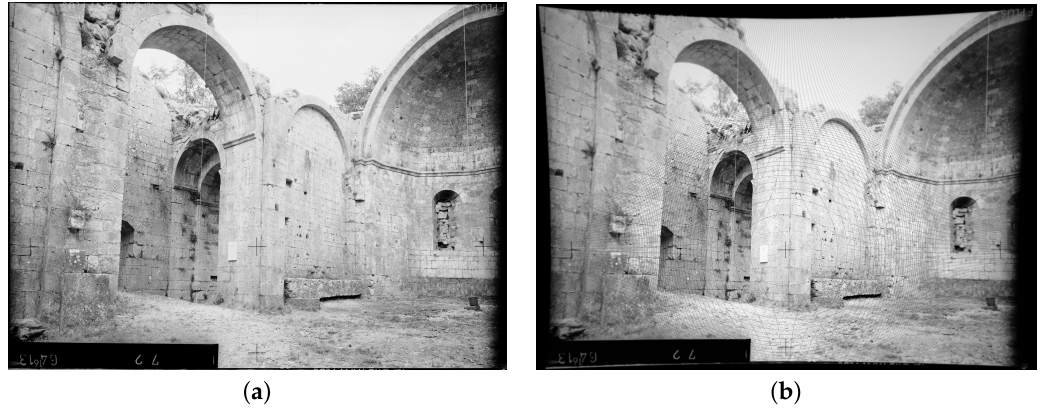
Figure 6. Distortion-less image taken using a small-format Wild P32 metric camera and application of an artificial distortion. ( a ) On the left, original image taken with P32 Wild metric camera; ( b ) On the right, pincushion distortion applied on this original image whithout interpolation. As images have not the same pixel size some vacant pixel are visible as black lines (see Hughues [32]). These lines surround the distortion center, here located on a fiducial mark, strongly shifted from the image center.